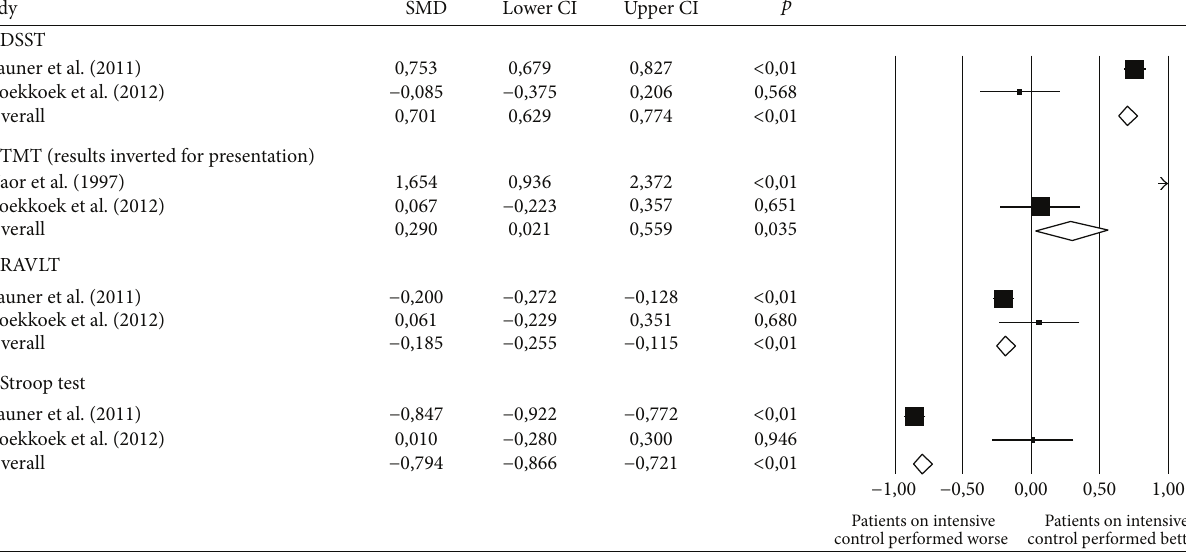
Figure 2: Summary of standardized mean differences for each cognitive test, divided by type of diabetes. Results for TMT have been mirrored for a more uniform